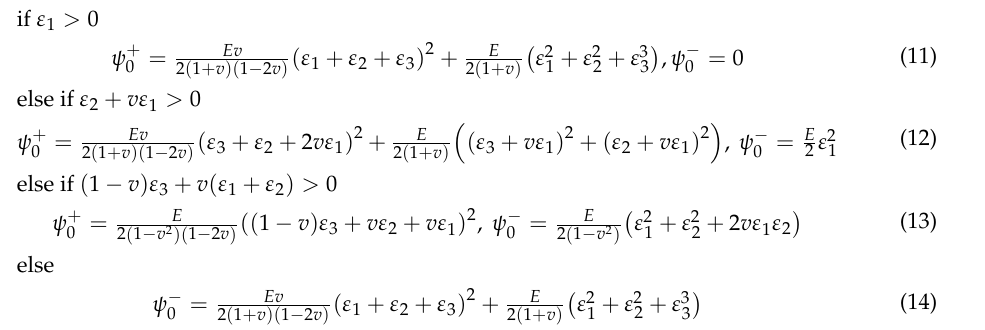
Table 3. Spectral split energy decomposition main equations, In the table, the well-known formula of the model firstly proposed in [30] are given for